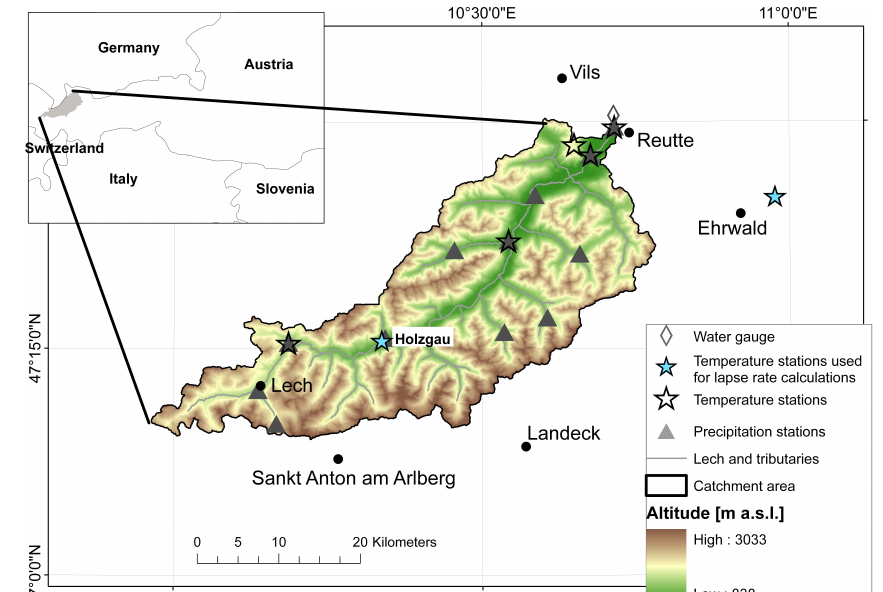
Fig. 1. Study area Lech